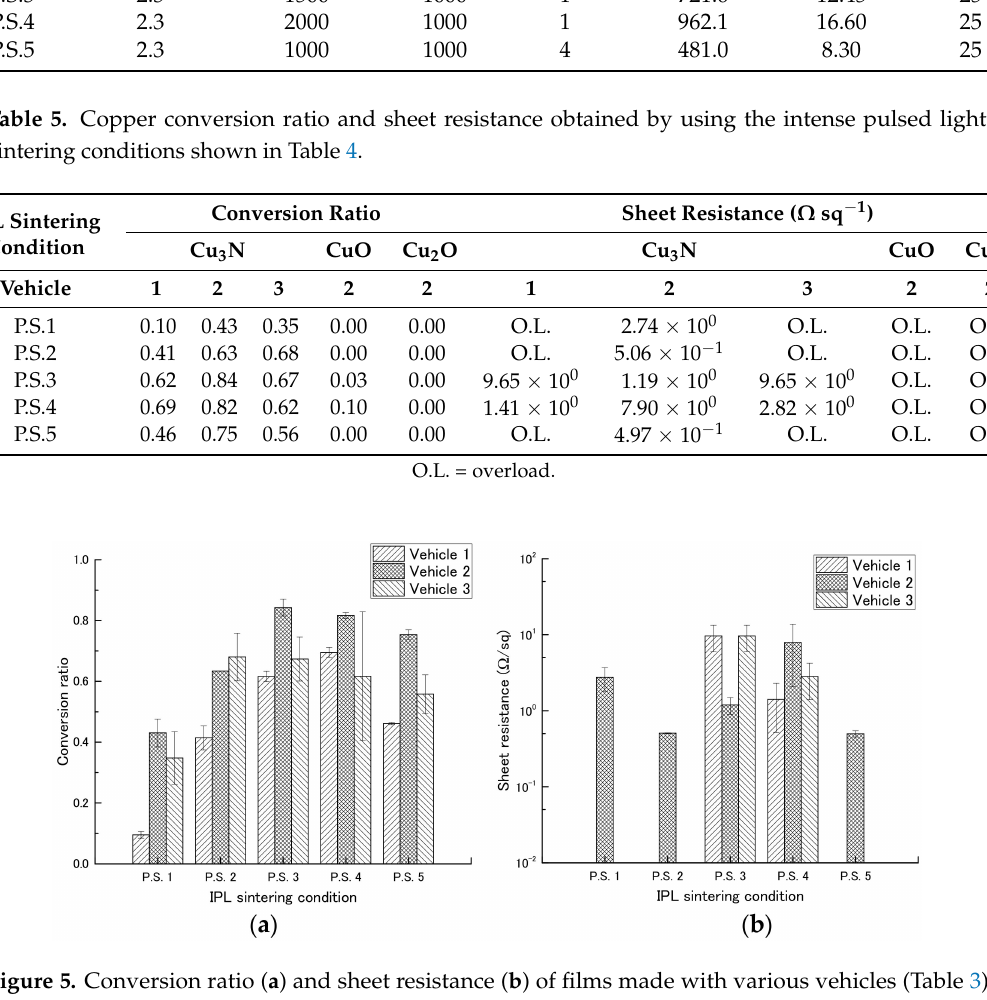
Figure 5. Conversion ratio ( a ) and sheet resistance ( b ) of films made with various vehicles (Table 3) and then exposed to intense pulsed light irradiation using the conditions shown in Table